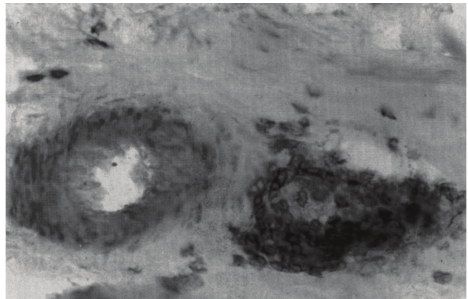
Figure 1: Biopsy of sural nerve in cross section in a patient with diabetic lumbosacral radiculoplexus neuropathy (DLRPN) demonstrates focal intense mononuclear inflammatory cells that surround and invade the wall of a small epineurial blood vessel on the right side of the photomicrograph indicative of microvasculitis (MV) (Cryosection, Immunoperoxidase, 400x).